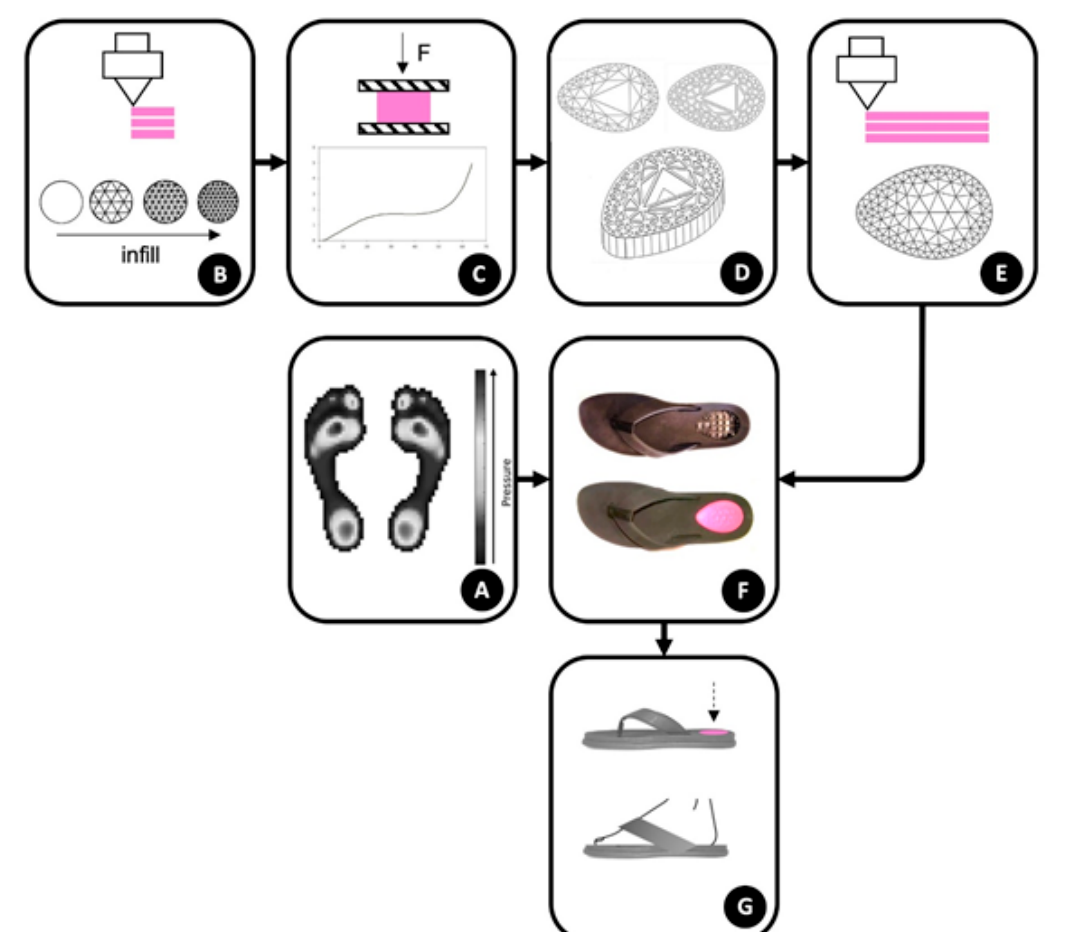
Figure 2. Methodology followed in the present work: ( A )—Identification of critical plantar pressure zones; ( B )—Printing of uniform mesh density structures; ( C )—Compression tests of the previous structures; ( D )—Generation of graded density structure inserts; ( E )—Printing of the inserts; ( F )—Production of prototype slippers (laser cut of insole, slipper assembly and insert placement); ( G )—Comfort assessment of prototype slippers (dynamic impact tests and assessment by a panel of users).